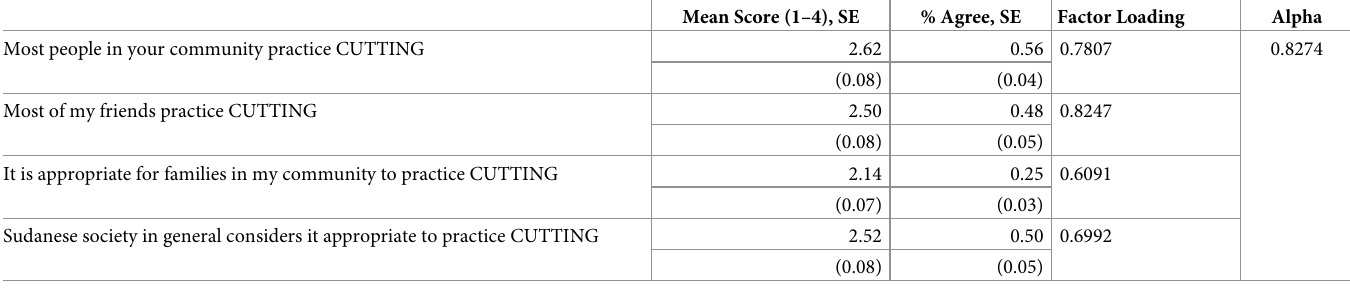
Table 2. FGM social